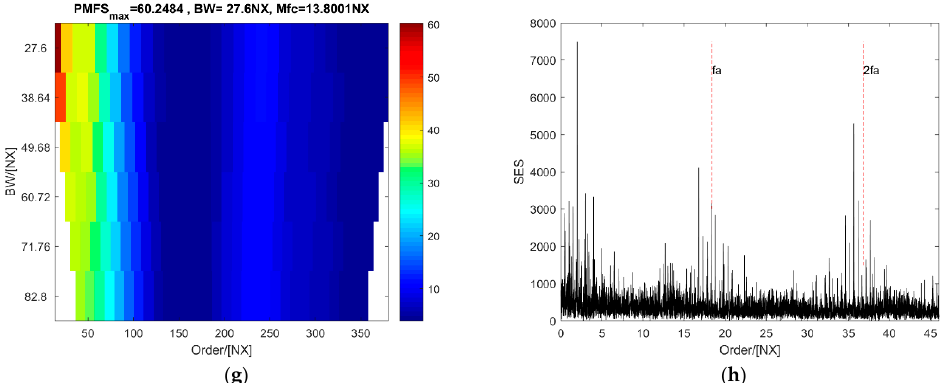
Figure 10. The analysis results of the case of outer ring defect with a constant speed: ( a , b ) the protugram and the SES of its optimal order band; ( c , d ) the PMgram and the SES of its optimal order band; ( e , f ) the enhanced kurtogram and the power spectrum of its optimal order band; ( g , h ) the PMFSgram and the SES of its optimal order band.